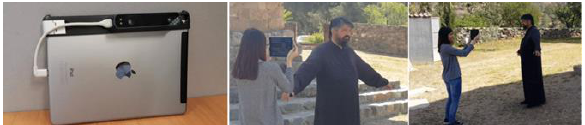
Figure 2. 3D reconstruction of the priest of the Asinou church (middle, right) using the occipital structure sensor